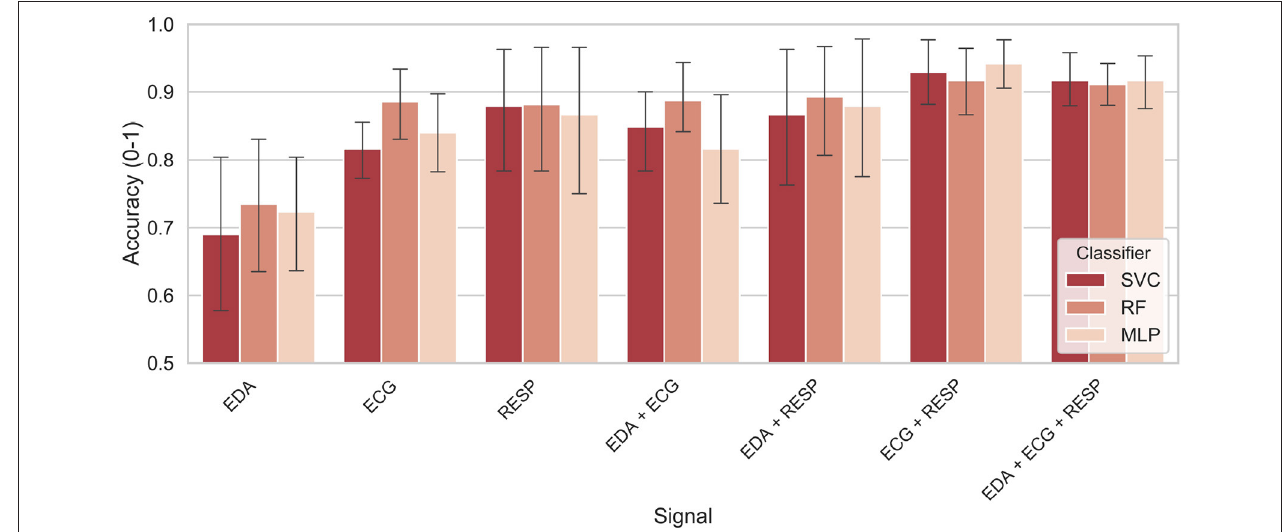
FIGURE 5 | Classification accuracy as a function of selected physiological signals and classifier.